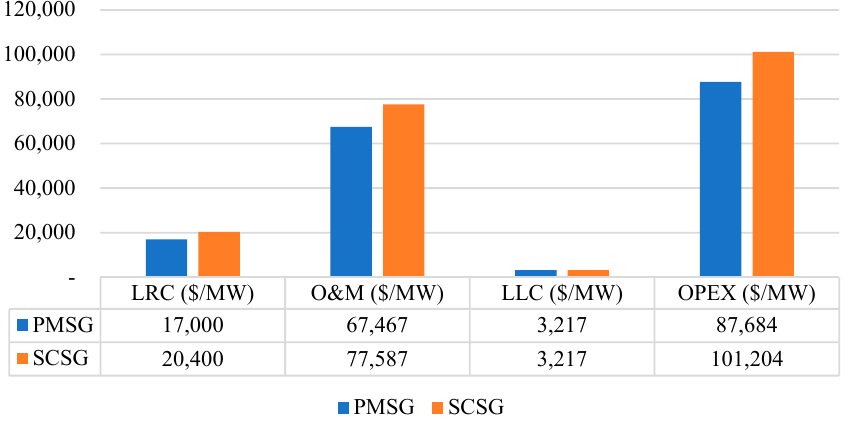
Figure 7. The OPEX of the PMSG and SCSG type FOWTs.